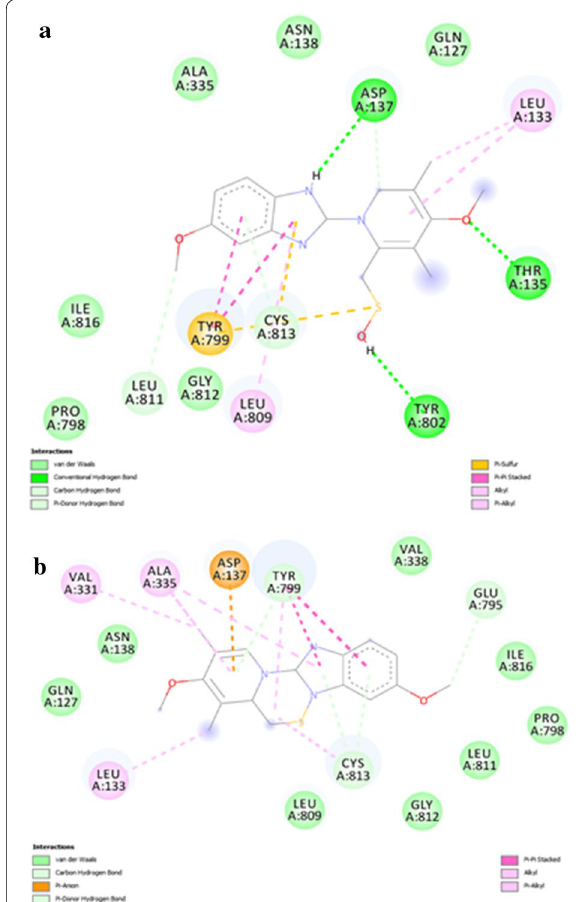
Fig. 10 Predicted interactions of omeprazole’s sulfenic acid ( a ) and sulfenamide ( b ) derivatives with active